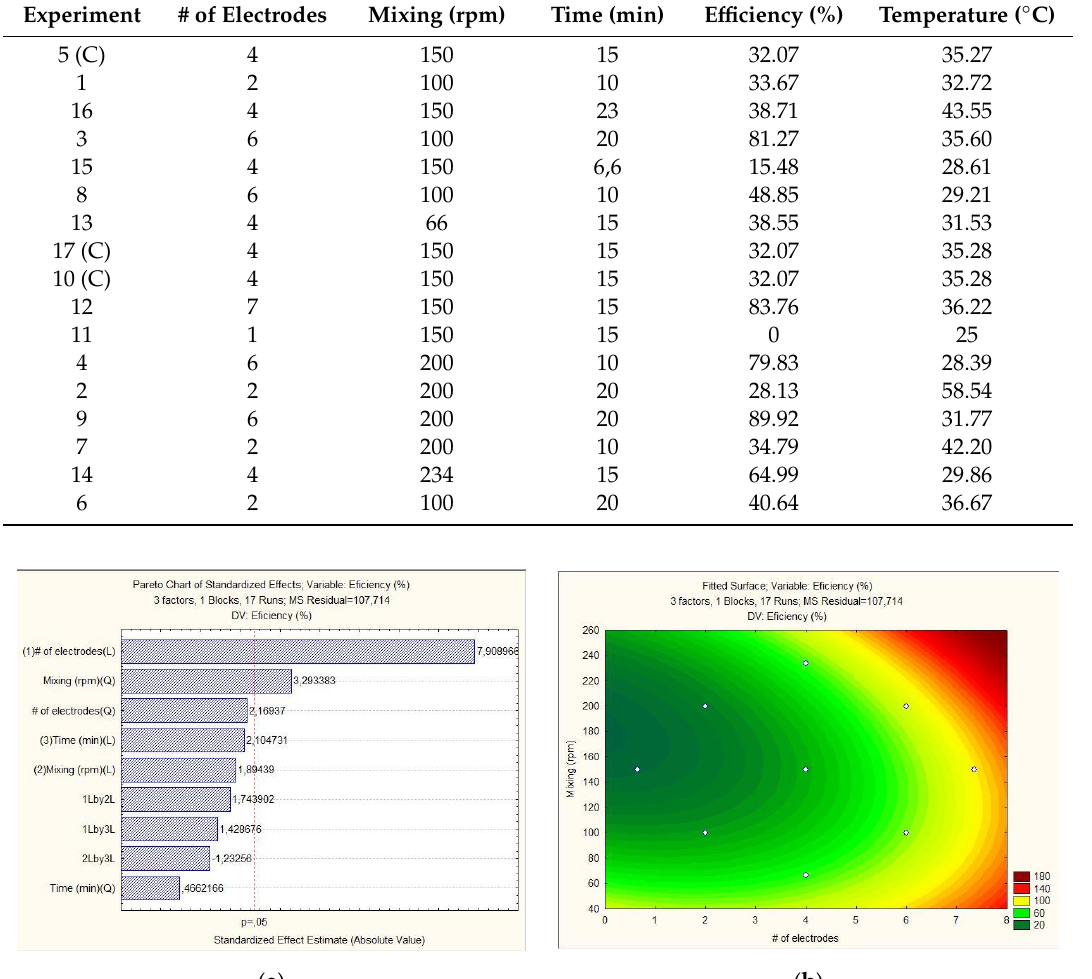
Table 2. The e ffi ciency of algae concentration and temperature of media.